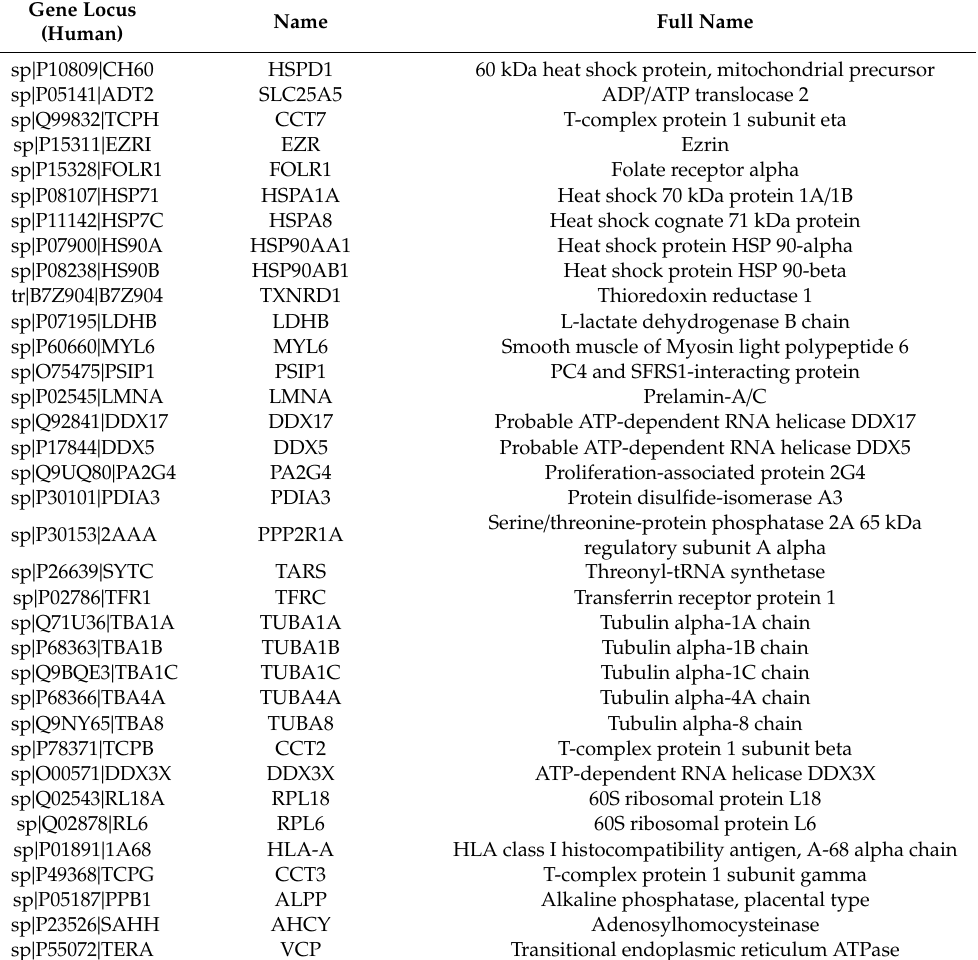
Table 1. Selected 35 proteins resistant to pronase with APZ treatment by LC–MS / MS analysis. Gene Locus